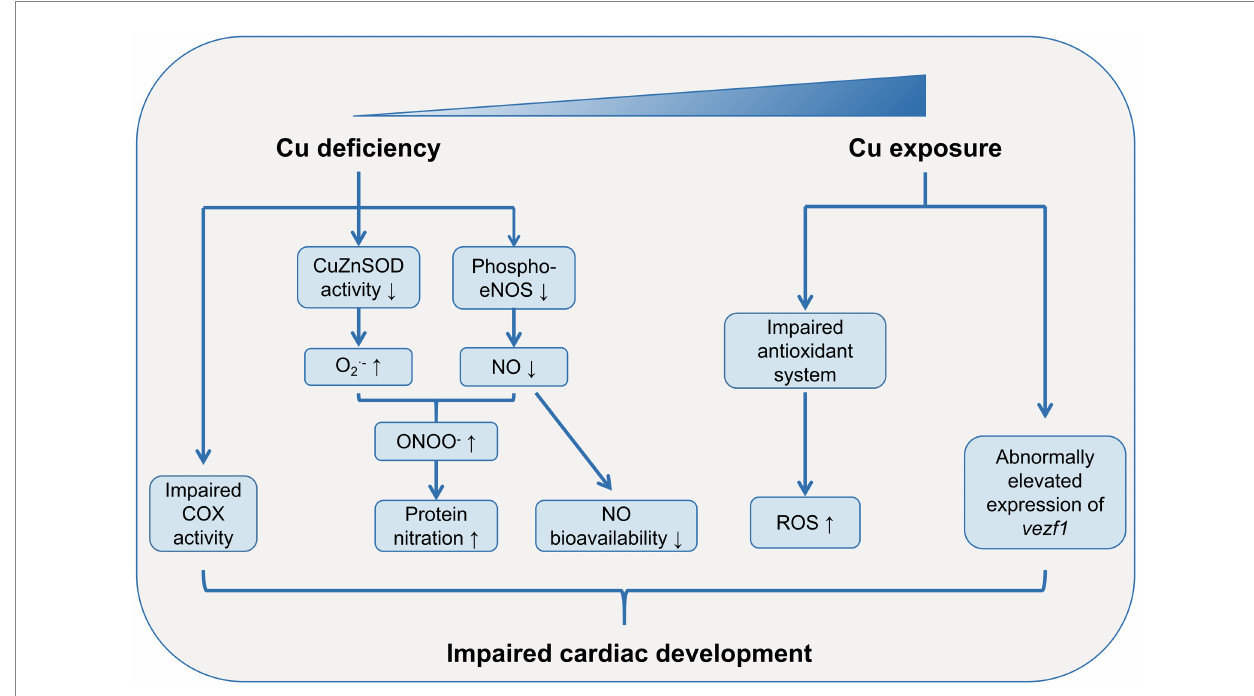
FIGURE 1 Role of Cu in cardiac development. Both Cu deficiency and excessive Cu exposure may lead to abnormal cardiac development. Cu deficiency dampens the activity of COX in cardiac mitochondria. Cu deficiency impairs anti-oxidant defense system, resulting in increased ROS levels in embryonic heart. Moreover, the large consumption of NO and decreased phosphorylation levels of eNOS due to Cu deficiency lead to low bioavailability of NO during heart development. Excessive Cu exposure can also impairs anti-oxidant defense system, leading to increased ROS levels in embryonic heart. Cu exposure also alters the expression patterns of development-related gene such as vezf1 , which may lead to abnormal cardiac development. COX, cytochrome-c oxidase; Cu, copper; CuZnSOD, Cu-Zn superoxide dismutase; eNOS, endothelial nitric oxide (NO) synthase; NO, nitric oxide; ROS, reactive oxygen species; vezf1 , vascular endothelial zinc finger